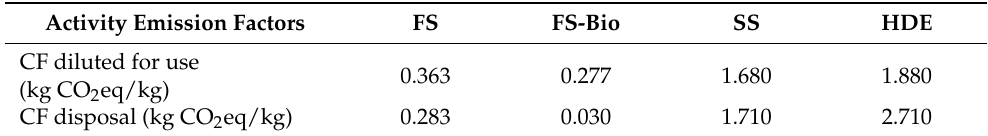
Table 6. Emission factors determined for each CF group